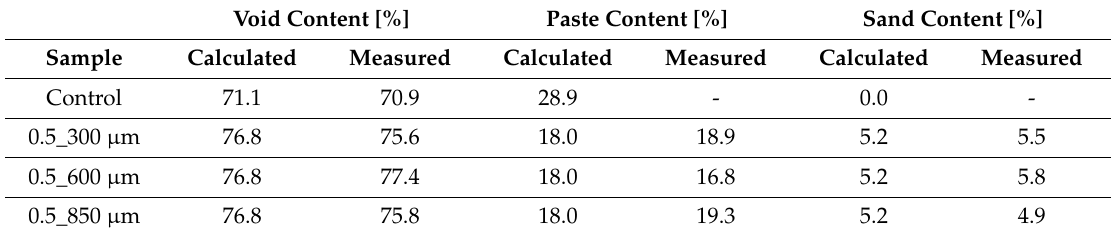
Table 3. Theoretical volume fractions and measurements from the 3D